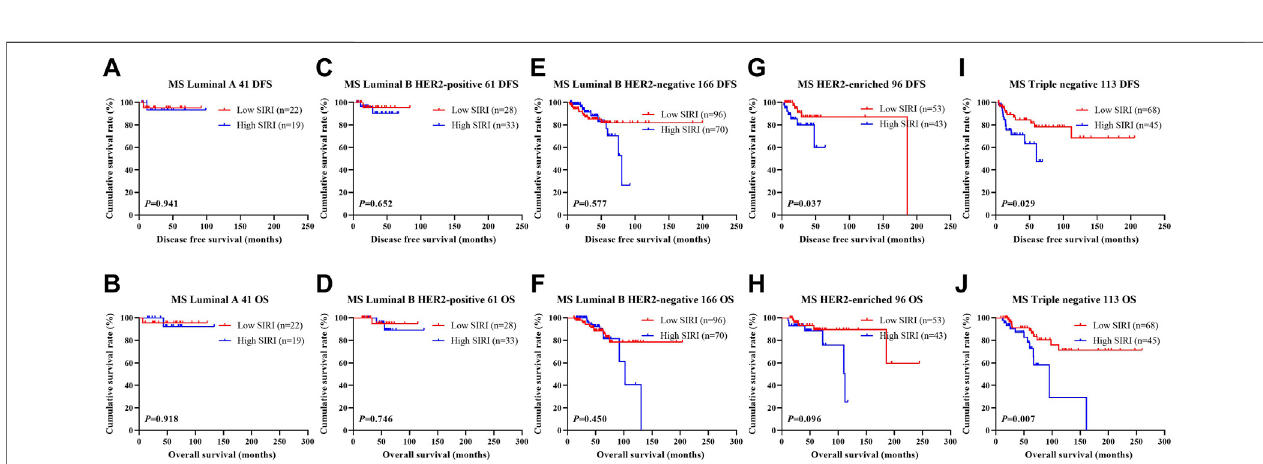
FIGURE 4 | DFS and OS based on SIRI scores in patients with breast cancer of various molecular subtypes (NACT group). (A) Kaplan-Meier analysis of DFS for the SIRI of patients with luminal A breast cancer. (B) Kaplan-Meier analysis of OS for the SIRI of patients with luminal A breast cancer. (C) Kaplan-Meier analysis of DFS for the SIRI of patients with luminal B HER2-positive breast cancer. (D) Kaplan-Meier analysis of OS for the SIRI of patients with luminal B HER2-positive breast cancer. (E) Kaplan-Meier analysis of DFS for the SIRI of patients with luminal B HER2-negative breast cancer. (F) Kaplan-Meier analysis of OS for the SIRI of patients with luminal B HER2-negative breast cancer. (G) Kaplan- Meier analysis of DFS for the SIRI of patients with HER2-overexpressing breast cancer. (H) Kaplan-Meier analysis of OS for the SIRI of patients with HER2- overexpressing breast cancer. (I) Kaplan-Meier analysis of DFS for the SIRI of patients with triple-negative breast cancer. (J) Kaplan-Meier analysis of OS for the SIRI of patients with triple-negative breast